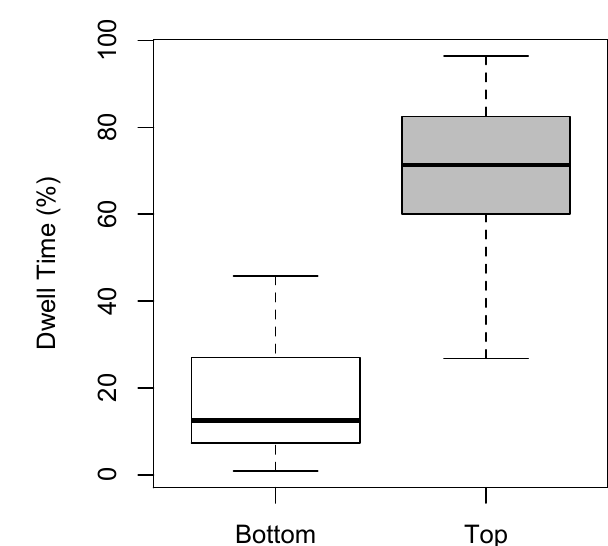
Figure 4. Boxplots of dwell time for ROI (bottom and top). Dwell time is expressed as a percentage per participant.